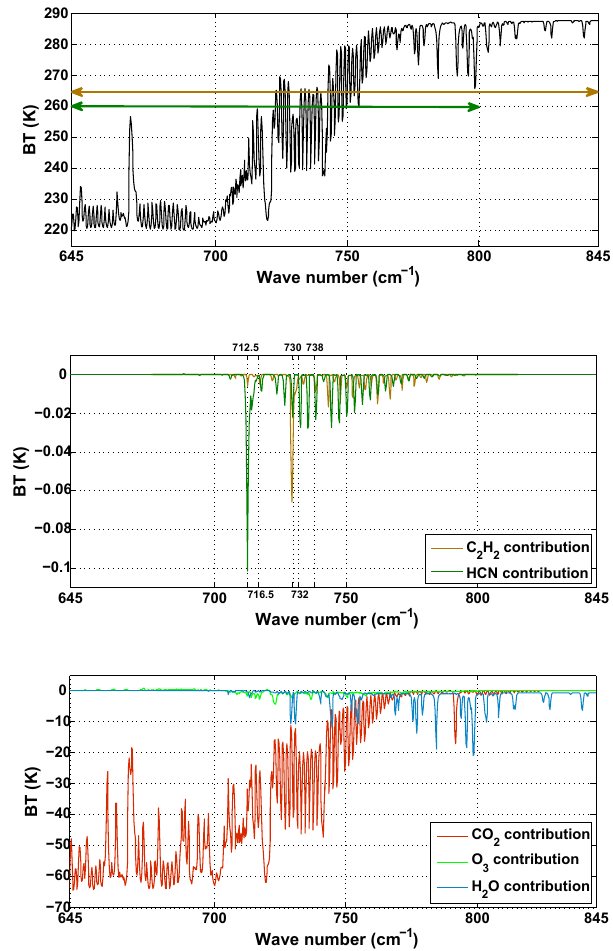
Figure 1. (Top) Simulated spectra in the region of the HCN ν 2 band and C 2 H 2 ν 5 band. The green (brown) double sided arrow gives the Figure 12. (Top) Simulated spectra in the region of the HCN ν 2 spectral range used to compute the S (cid:15) matrices for HCN (C 2 H 2 ). band and C 2 H 2 ν 5 band. The green (brown) double sided arrow (Middle) contributions of climatological background levels of HCN gives the spectral range used to compute the S (cid:15) matrices for HCN and C 2 H 2 . (Bottom) contribution of CO 2 (red line), O 3 (green line) (C 2 H 2 ). (Middle) Contributions of climatological background lev- and H 2 O (blue line) to a simulated spectrum for background con- els of HCN and C 2 H 2 . (Bottom) Contribution of CO 2 (red line), centrations. Calculations have been made for the US standard atmo- O 3 (green line) and H 2 O (blue line) to a simulated spectrum for sphere (Standard Atmosphere: National Atmospheric and Oceanic background concentrations. Calculations have been made for the Administration, 1976) with CO 2 concentrations scaled to